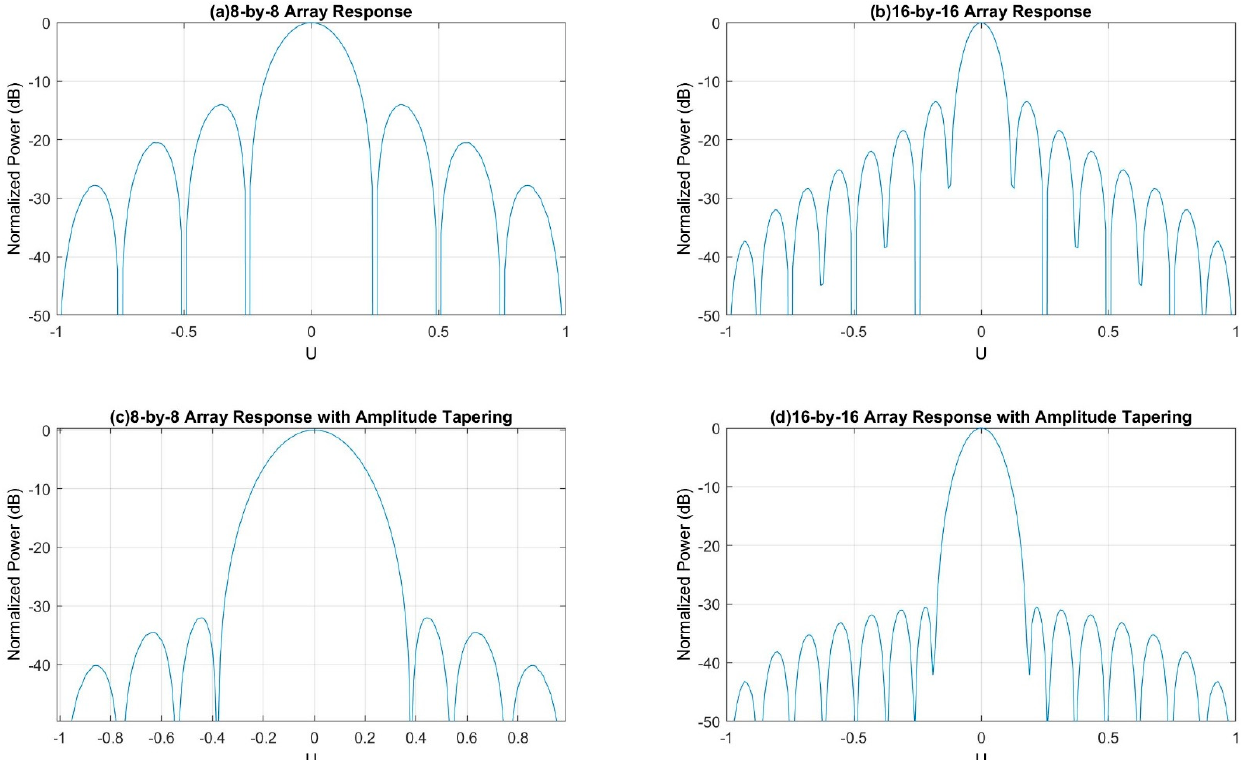
Figure 10. Normalized power distribution of the array (i.e., 8-by-8 and 16-by-16 array) with and without amplitude tapering.